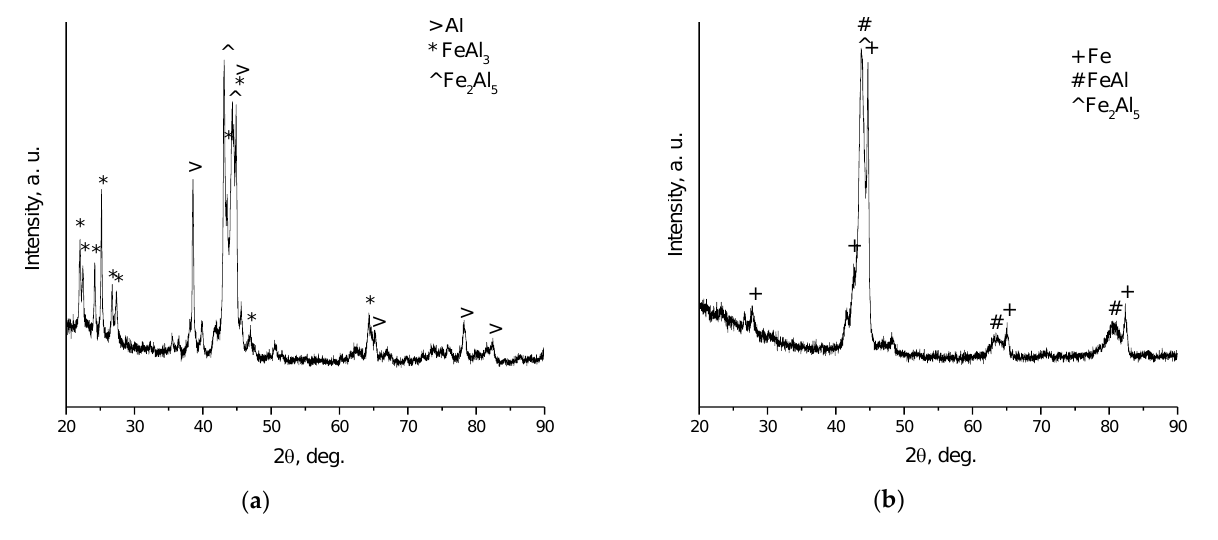
Figure 11. ( a ) XRD pattern of the material obtained by SPS of Al-Fe (4:1 mol.) mixture. SPS conditions: temperature—570 ◦ C, holding time—3 min, applied pressure—40 MPa. ( b ) XRD pattern of the material obtained by HP of the Al-Fe mixture (3:2 mol.). HP conditions: temperature—650 ◦ C, holding time—5 min, applied pressure—3 MPa.